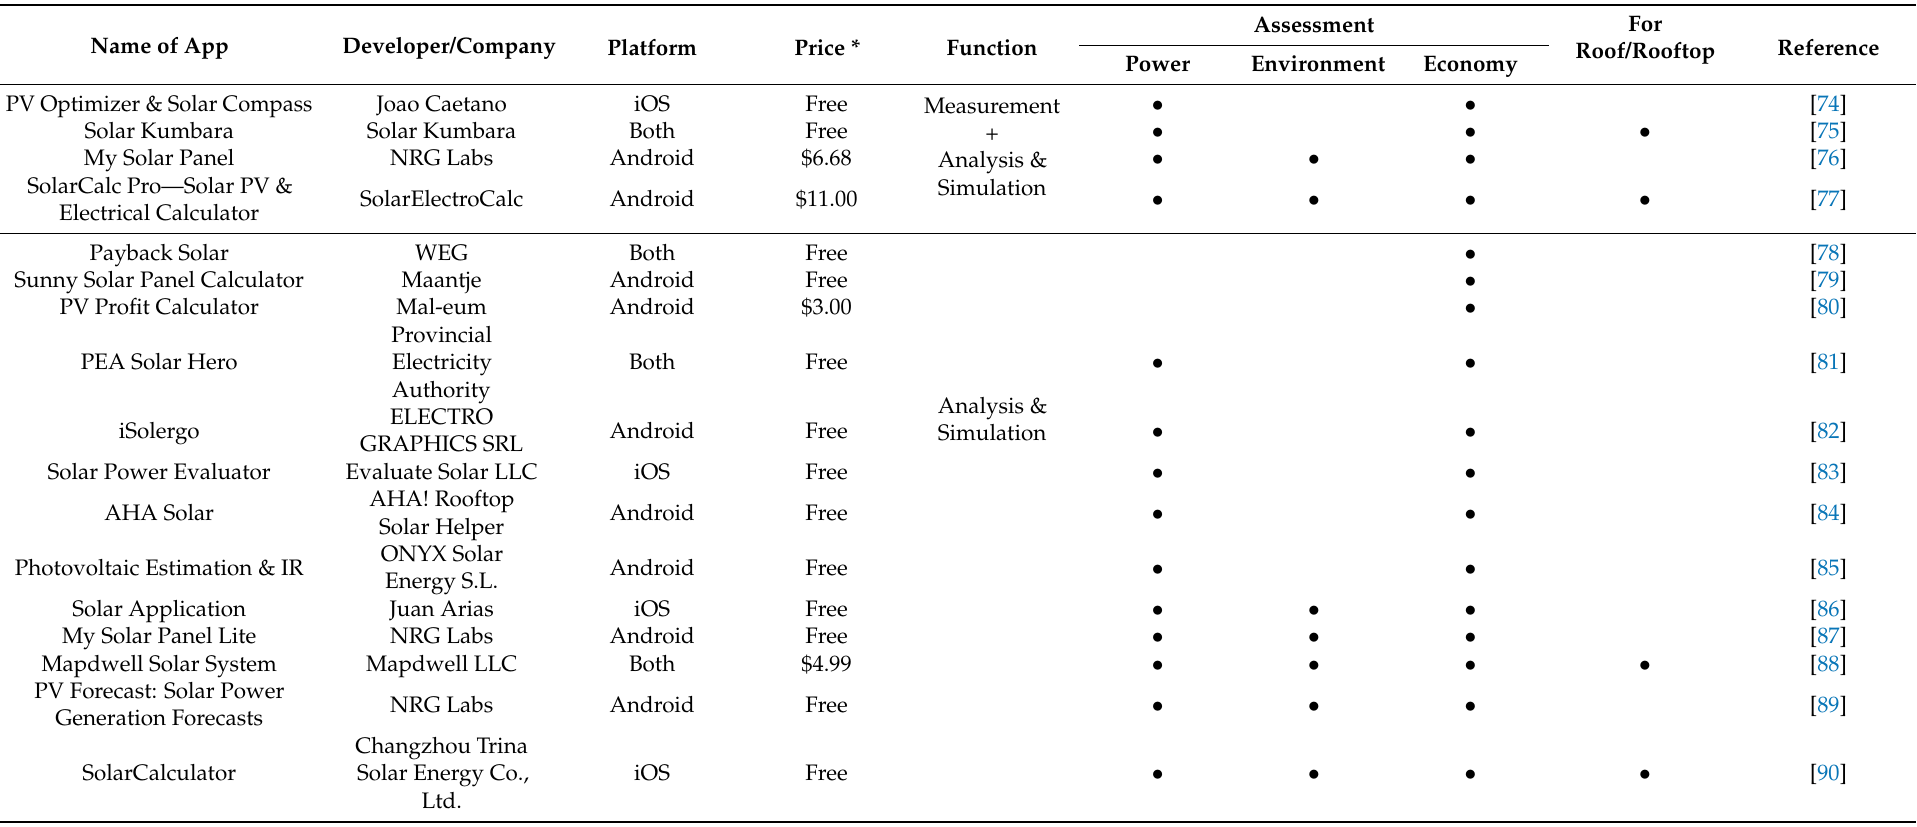
Table 7. Summary of smartphone applications for environmental and economic assessments of PV